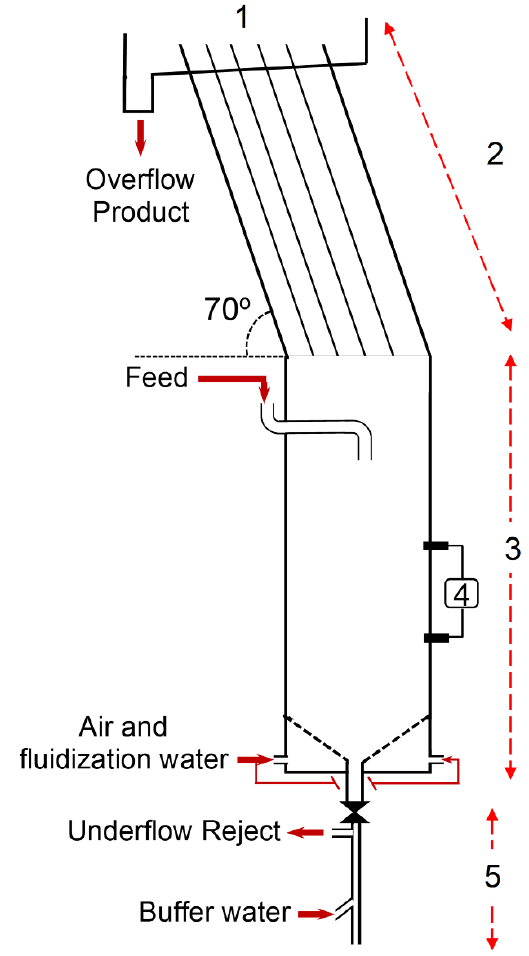
Figure 1. Schematic view of the CoarseAIR™. (1) Overflow launder, (2) inclined channels, (3) vertical fluidized bed column, (4) differential pressure sensor, (5) buffer system to moderate underflow discharge.